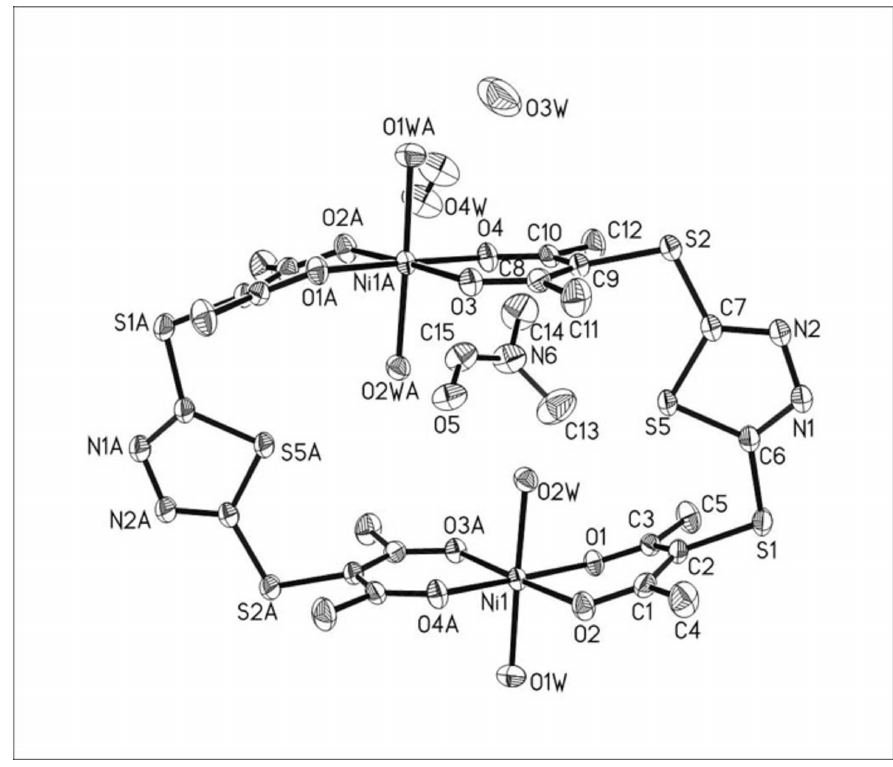
The molecular structure of the title compound with the atom-labeling scheme. Displacement ellipsoids are drawn at the 30% probability level.